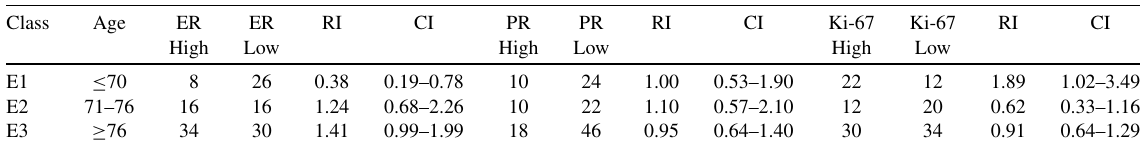
Relative Incidence (RI) and the confidence interval (CI)